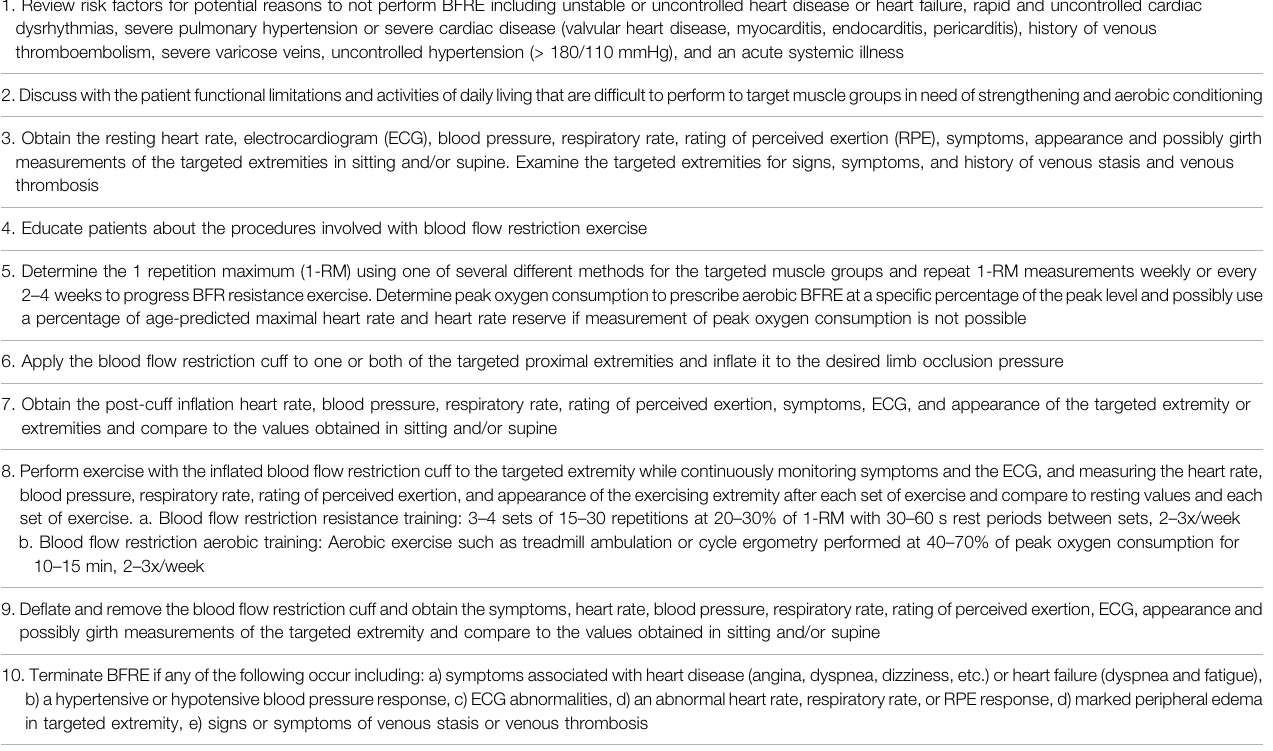
TABLE 5 | Suggested methods to perform blood fl ow restriction training safely in patients with heart disease and heart failure. 1. Review risk factors for potential reasons to not perform BFRE including unstable or uncontrolled heart disease or heart failure, rapid and uncontrolled cardiac dysrhythmias, severe pulmonary hypertension or severe cardiac disease (valvular heart disease, myocarditis, endocarditis, pericarditis), history of venous thromboembolism, severe varicose veins, uncontrolled hypertension ( > 180/110 mmHg), and an acute systemic